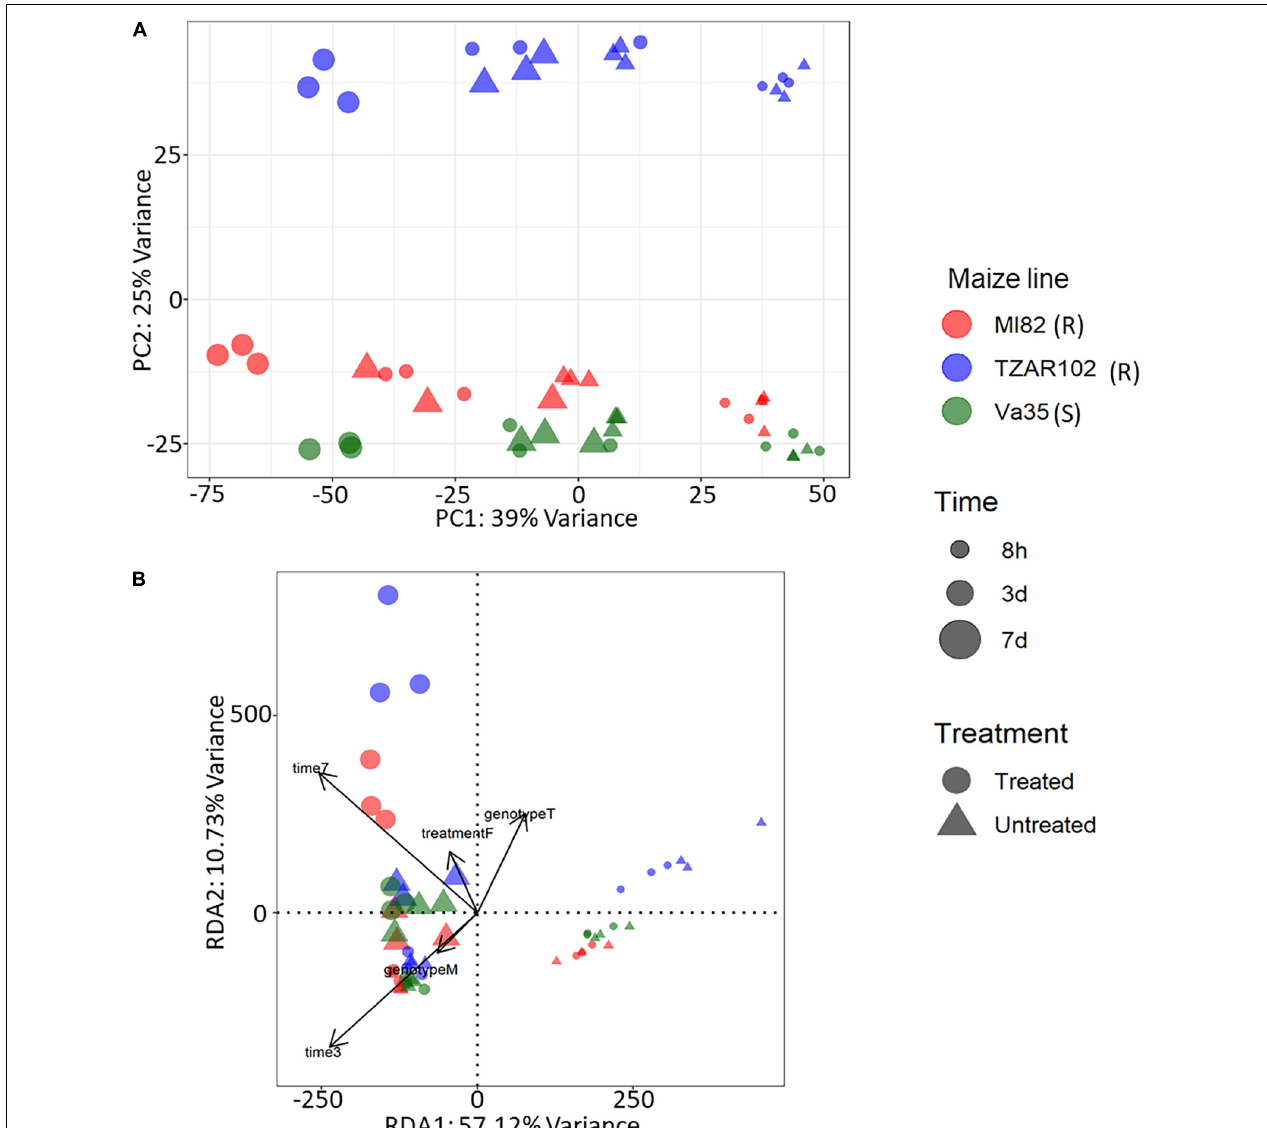
FIGURE 1 | Gene expression profiles from KSA using (A) principal component analysis, x-axis explained 39% of variance and y-axis explained 25% of variance. PCA was performed using rlog-transformed count data from DESeq2. (B) Expression profiles using redundancy analysis model, x-axis explained 57.1% of variance and y-axis 10.73% of variance. RDA was performed using rlog-transformed count data from DESeq2. PCA and RDA were performed using three corn lines and three time points of treated (Fungus) and untreated (Buffer) samples. Corn lines are identified by color, red, MI82 (R – Resistant); blue, TZAR102 (R – Resistant); green, Va35 (S – Susceptible). Figure shape represents treatment, circle, treated (Fungus) and triangle, untreated (Buffer). Time post treatment is represented in the size of the shapes, smallest, 8h; medium, 3d; largest,